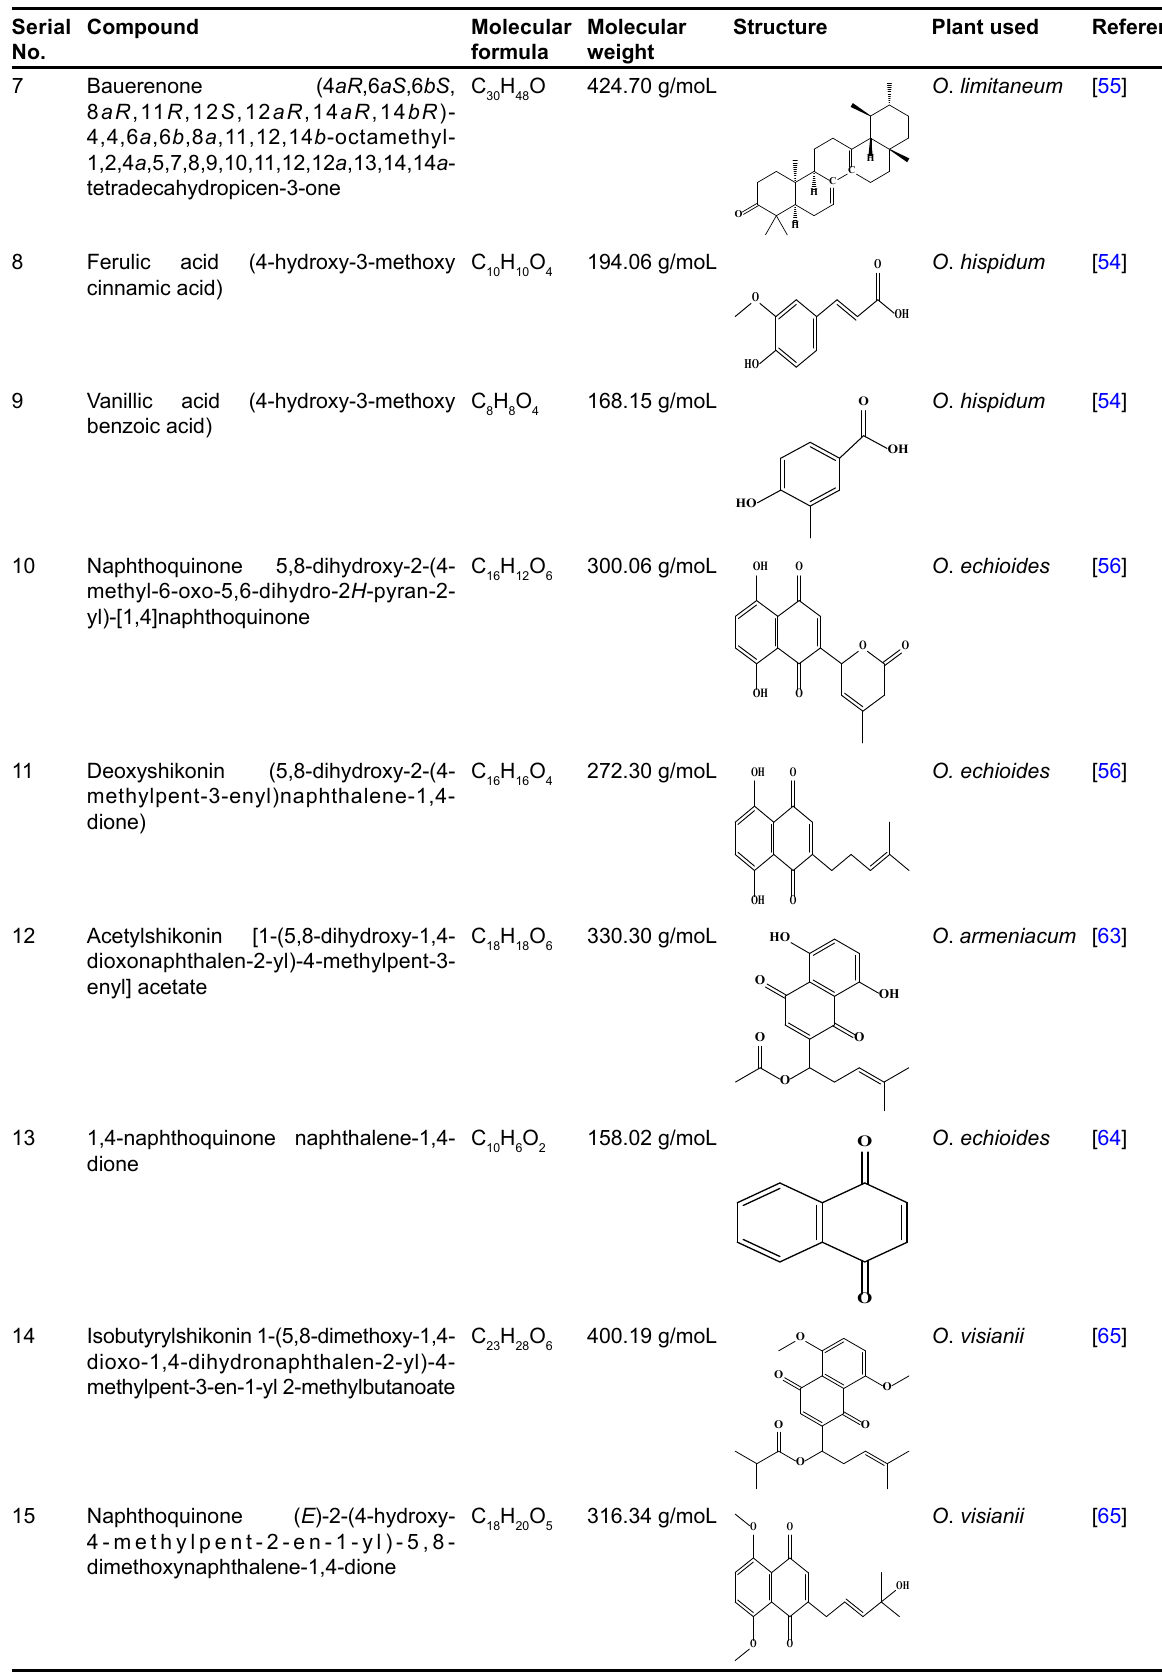
Table 1. Phytoconstituents procured from genus O . ( continued )